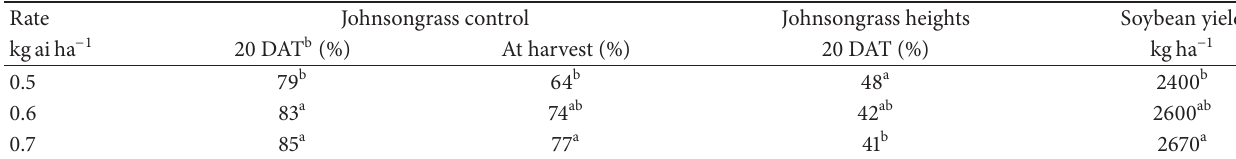
Table 2: Glyphosate-resistant rhizomatous johnsongrass control 20 d after treatment (DAT) and at harvest and heights as a percent of the nontreated 20 DAT and soybean yield as influenced by POST1 glufosinate application rate a